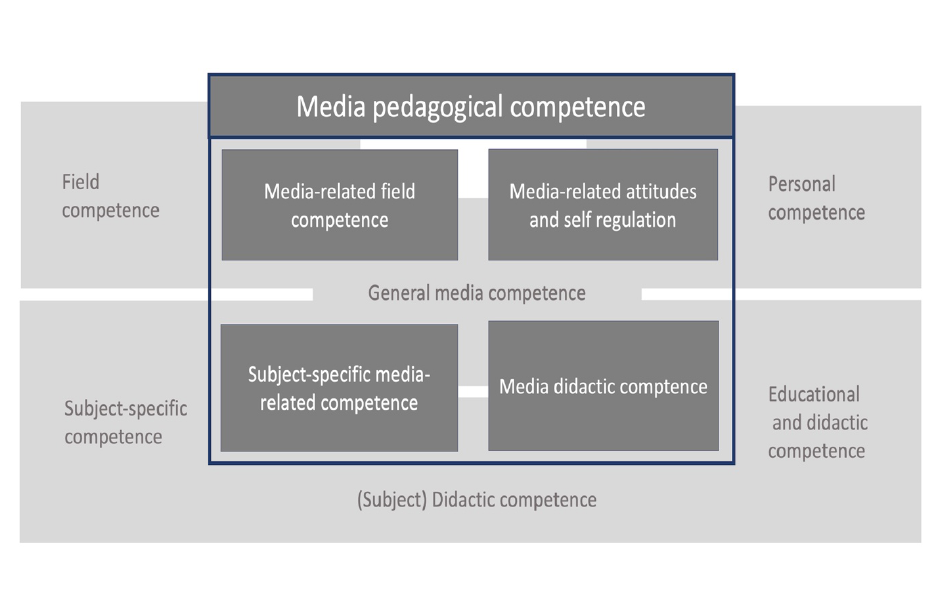
Figure 1: Model of media pedagogical competence for adult educators (Schmidt-Hertha et al., 2017)